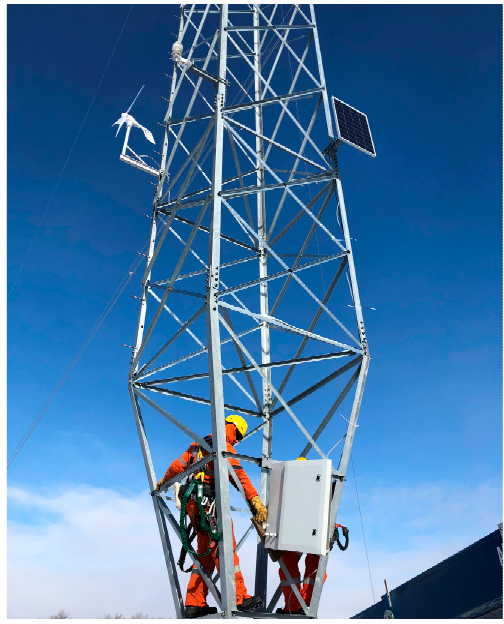
Figure 9. Gateway mounted on the tower nearest to the instrumented span.